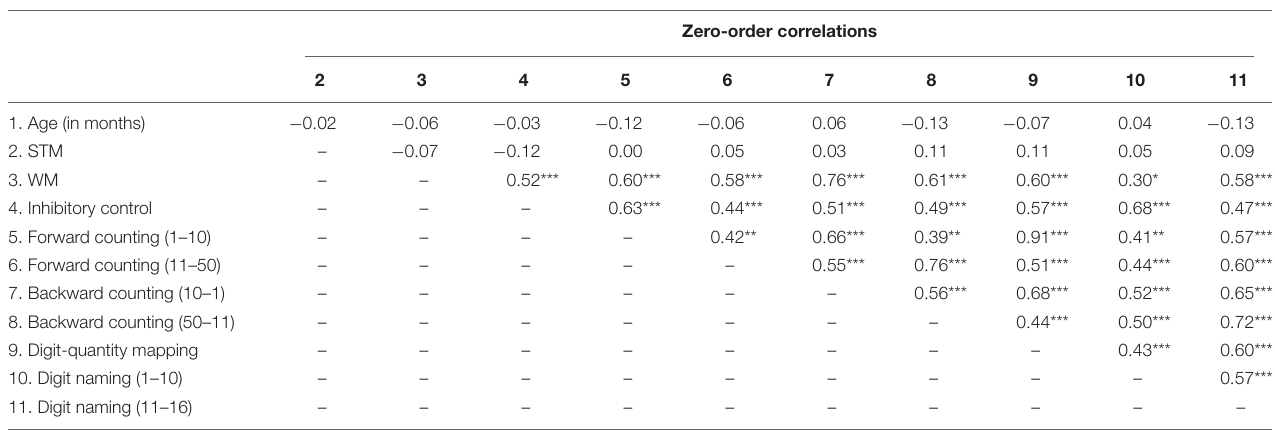
TABLE 3 | Bivariate correlations between all variables considered in the study for Italian children ( n = 55).